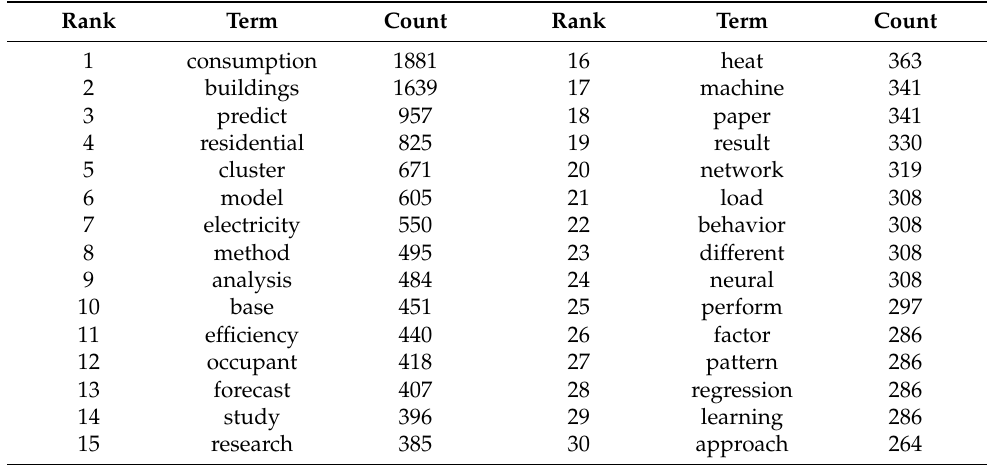
Table 8. Top 30 common terms ranked by higher word count, on the topic of “intelligent computing techniques” applied to